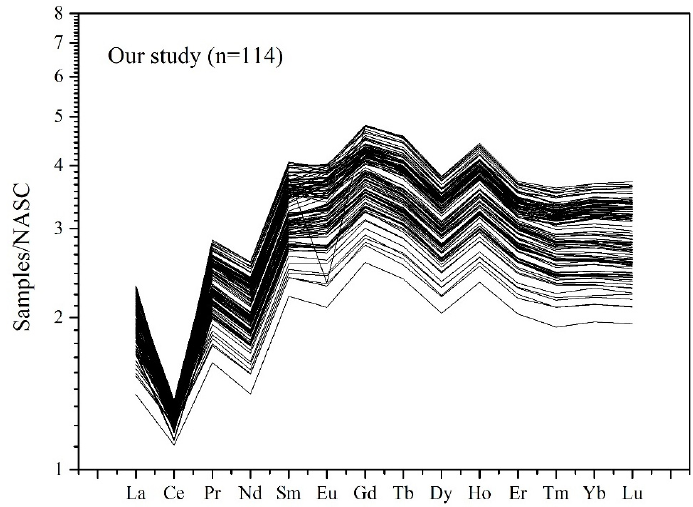
Figure 5. The NASC-normalized REE patterns in GC04 core. Note: δ Eu value of layer 515–520 cm is just 0.55, significantly lower than the adjacent layers, which may have been caused by systematic these data. NASC-normalized values are given by